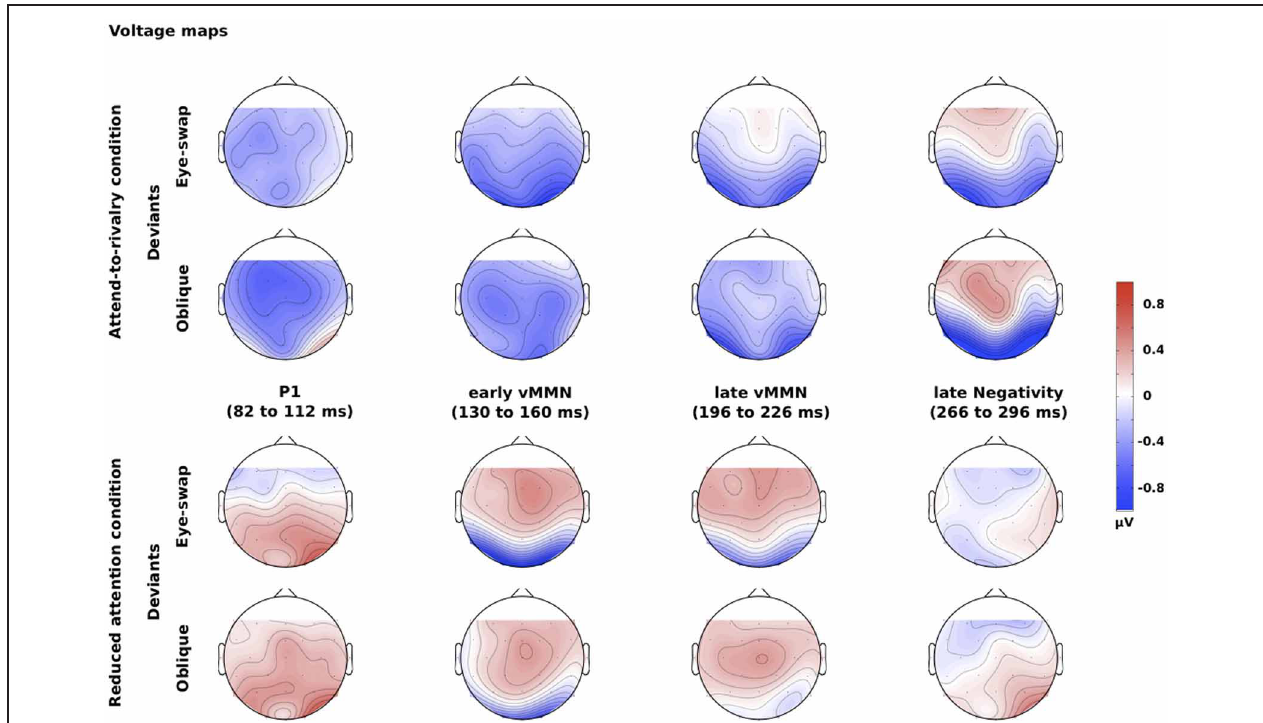
FIGURE 3 | Voltage maps for the differences between deviants and standards for different times after onset of the stimuli. The top two rows show the maps for the attend-to-rivalry condition; the bottom two rows show